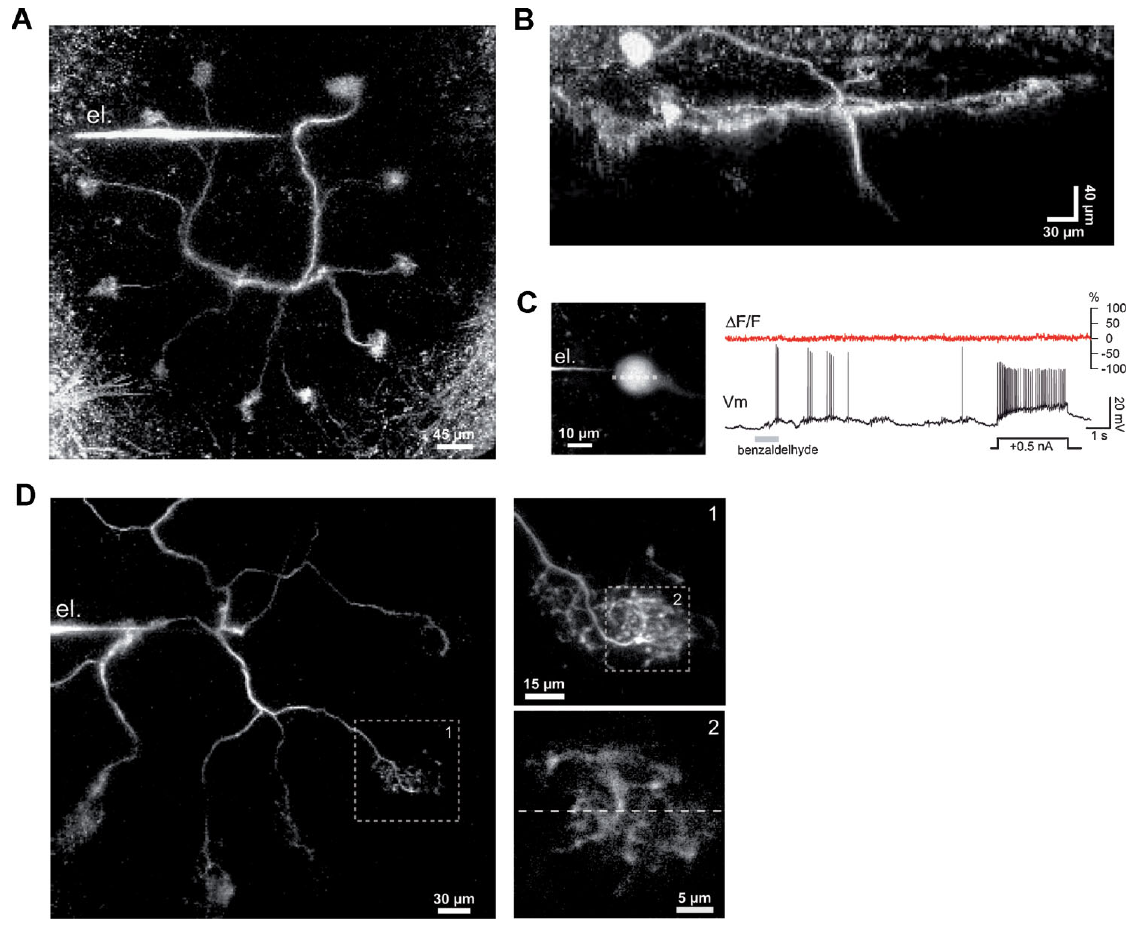
Figure 1. In vivo two-photon imaging of the calcium indicator OGB-1 in locust projection neurons (PNs) . ( A ) Frontal view of a PN labeled from a secondary dendrite via the recording electrode (el.). Eleven of the PN’s 12 glomerular tufts can be seen, forming a circle in one plane. The soma and axon, respectively above and below the dendritic plane, are not included in this projection. ( B ) Side projection of a different PN, showing the soma (top left; typically on the antenna lobe’s frontal surface), the plane of glomerular projections (view orthogonal to that in A ), and part of the axon (pointing down). Fluorescence intensity was kept roughly constant over the image depth by tuning the laser excitation intensity. ( C ) Simultaneous voltage (V m ) and OGB-1-imaging ( ∆ F/F, 500Hz) recorded after dye injection into the soma (PN different from those in A - B ): no significant changes in calcium signal could be induced by odor-evoked activity or current injection. ( D ) Dendritic impalement configuration typical for simultaneous calcium imaging and voltage recording (PN different from those in A - C ): within 10minutes of impalement, one or several tufts could be seen (box 1); a 30 × 30 µ m 2 area was then selected for line scans (stippled line, box